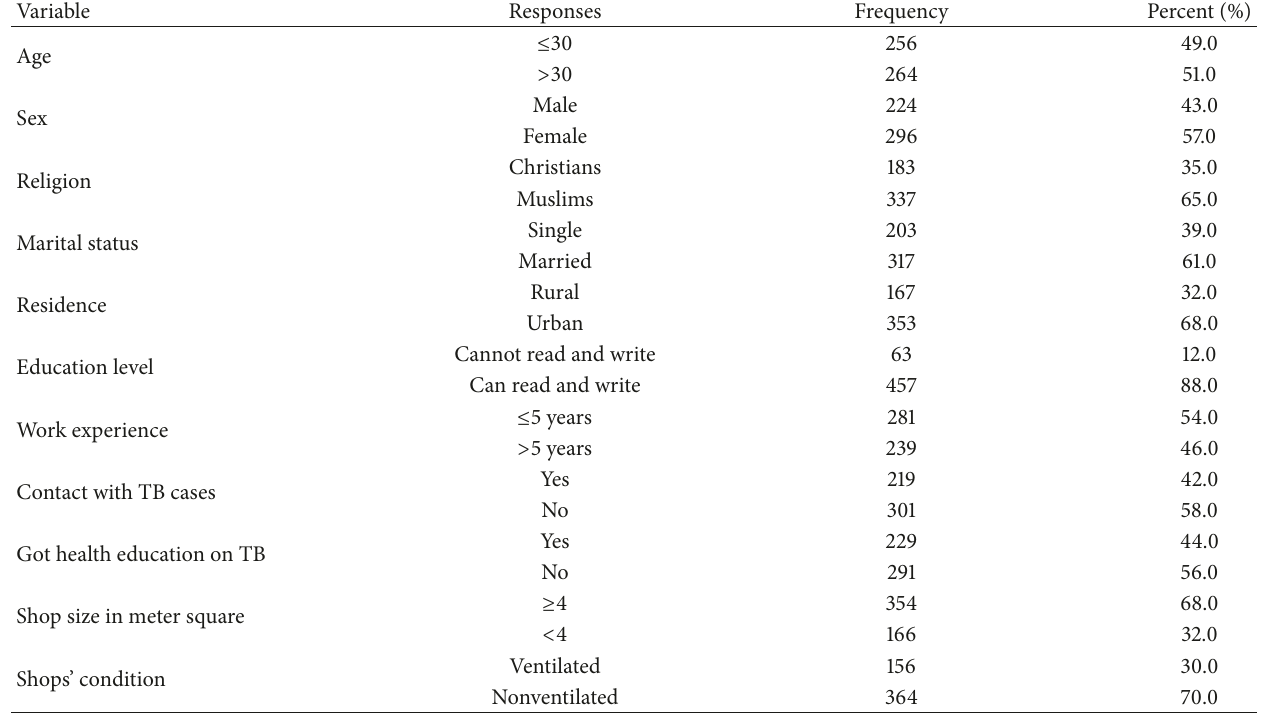
Table 1: Sociodemographic variables of shopkeepers in Bahir Dar City, Ethiopia,